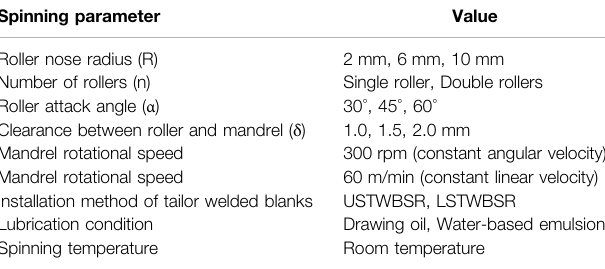
TABLE 3 | Experimental conditions of spinning with tailor welded blanks. Spinning parameter